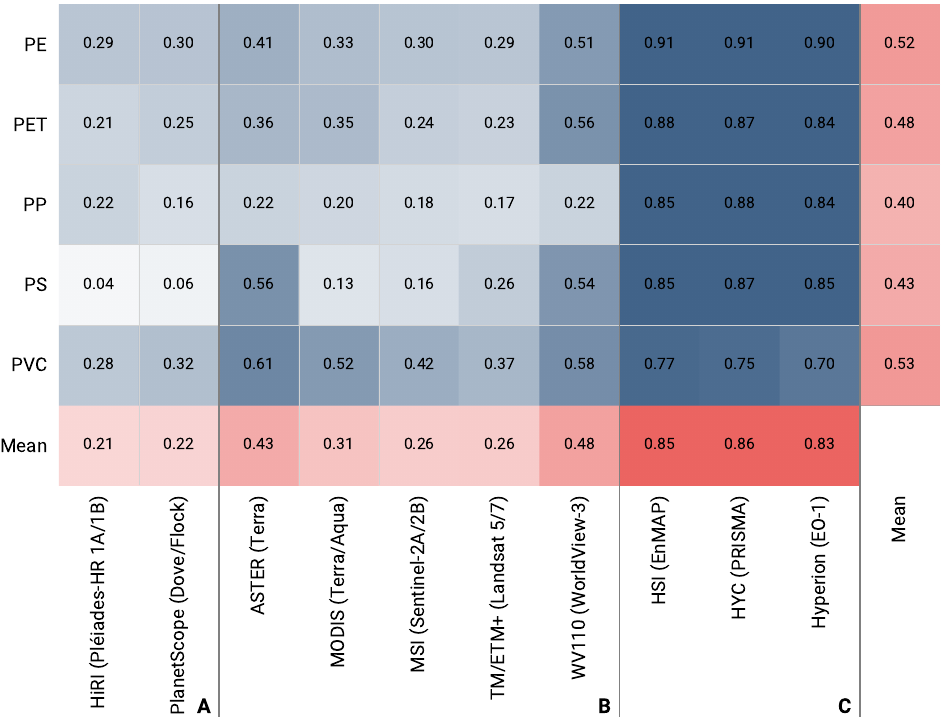
Figure 10. Mean F1 scores in dependence of sensor and plastic type using RF. ( A ) Multispectral VNIR sensors, ( B ) multispectral VNIR/SWIR sensors, and ( C ) hyperspectral sensors. No noise was added to the simulated reflectance